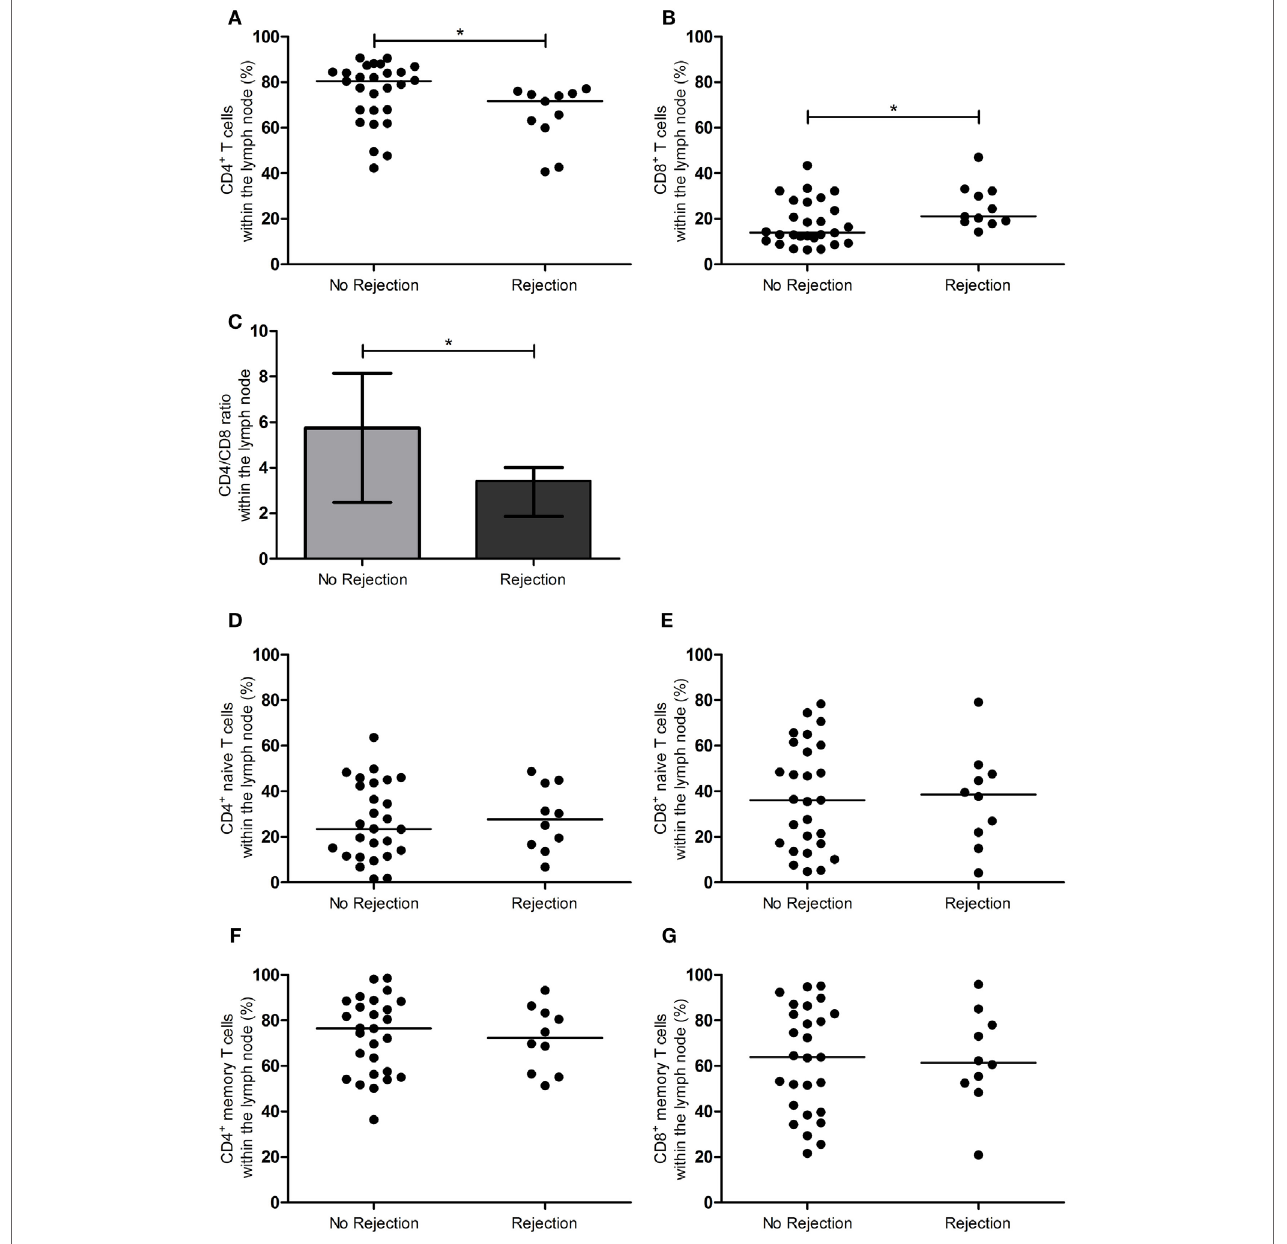
FigUre 1 | CD4 + and CD8 + T-cell subsets in the lymph node between rejection and no rejection groups. (a) Frequencies of CD4 + T cells and (B) CD8 + T cells, (c) CD4:CD8 ratio, (D) frequencies of CD4 + naïve T cells, (e) CD8 + naïve T cells, (F) CD4 + memory T cells, and (g) CD8 + memory T cells within the lymph nodes are shown between the no rejection and rejection groups. Data are presented with individual percentages and medians or bars with interquartile range and medians. Significant differences were calculated and shown (* p < 0.05, ** p ≤ 0.01, *** p ≤